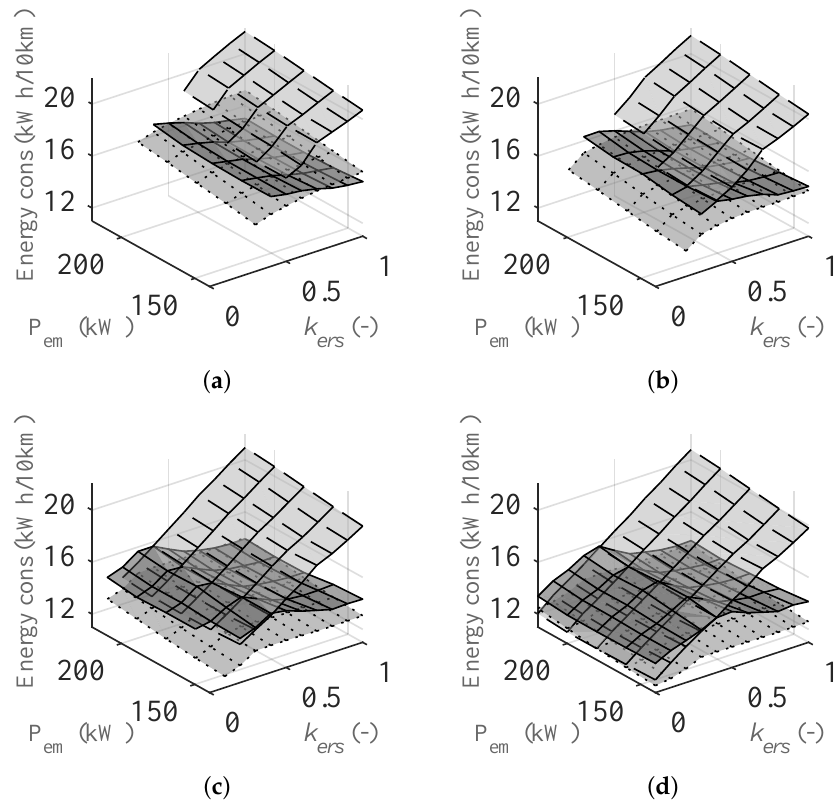
Figure 13. Energy consumption (kWh/10 km) of a city bus on “City bus route 85” utilising the minimum switching (MnSW) control strategy as a function of the rated power of each traction machine, P em , and the ratio of ERS-coverage, k ers , with d ers = 1 km. Each subfigure represents a specific amount of battery capacity; ( a ) area with dashed lines and a light grey surface is the LSETS; the area with dotted lines and light grey is the HSETS; and the dark grey area is the